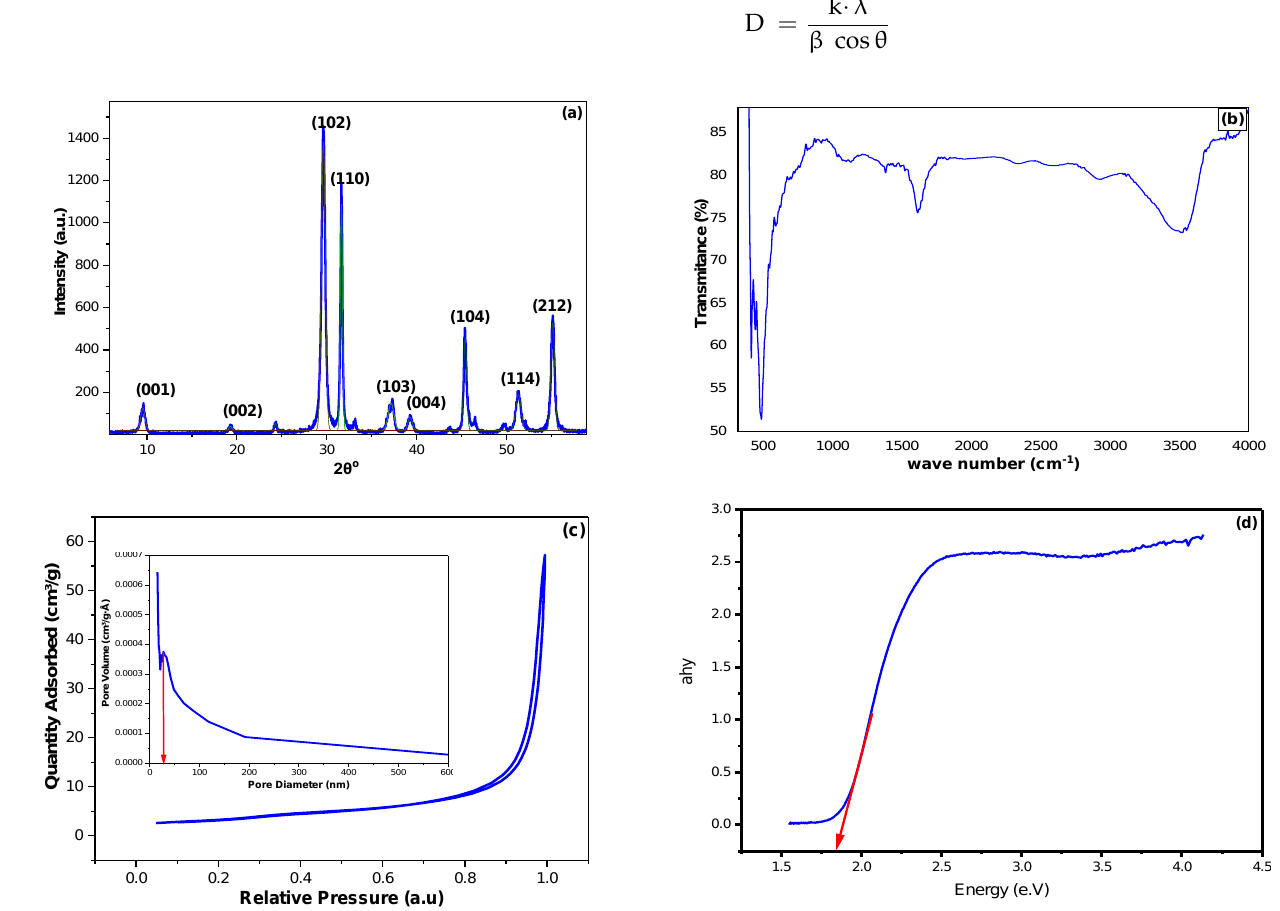
Figure 4. ( a ) XRD pattern for the synthesized BiOI nanoparticles; ( b ) the FT-IR vibration bands for